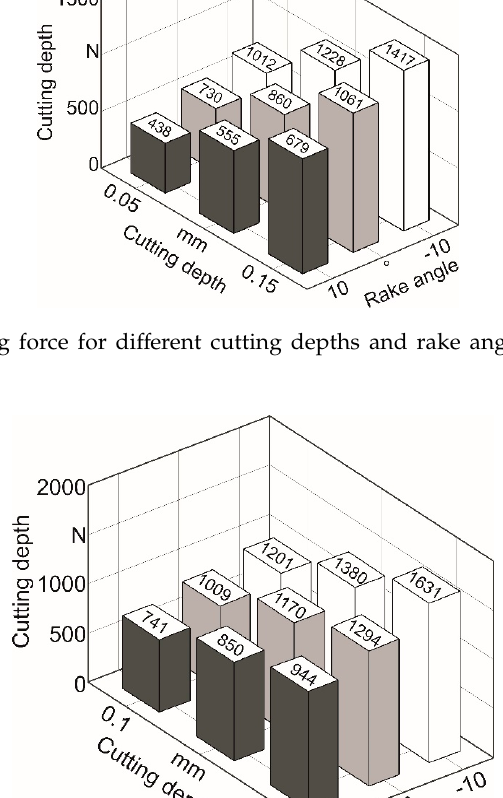
Figure 4. Plot of cutting force for different cutting depths and rake angles in the machining of AISI 1045 steel.